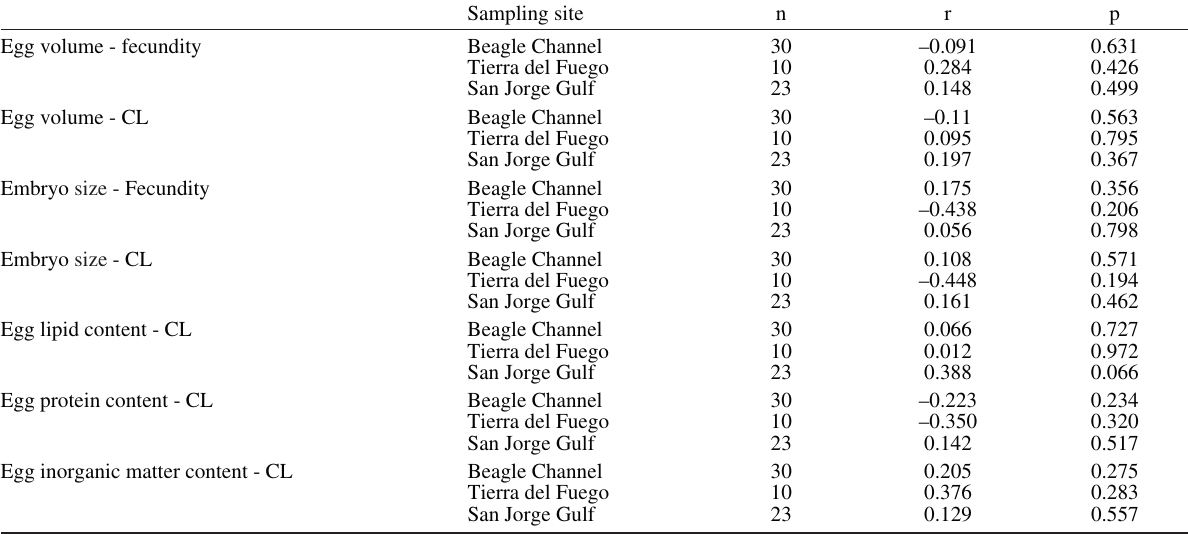
Table 2. – Pearson correlation between egg volume, embryo size, fecundity, egg lipid, protein and inorganic matter content and female size (CL), among the three sampling sites.